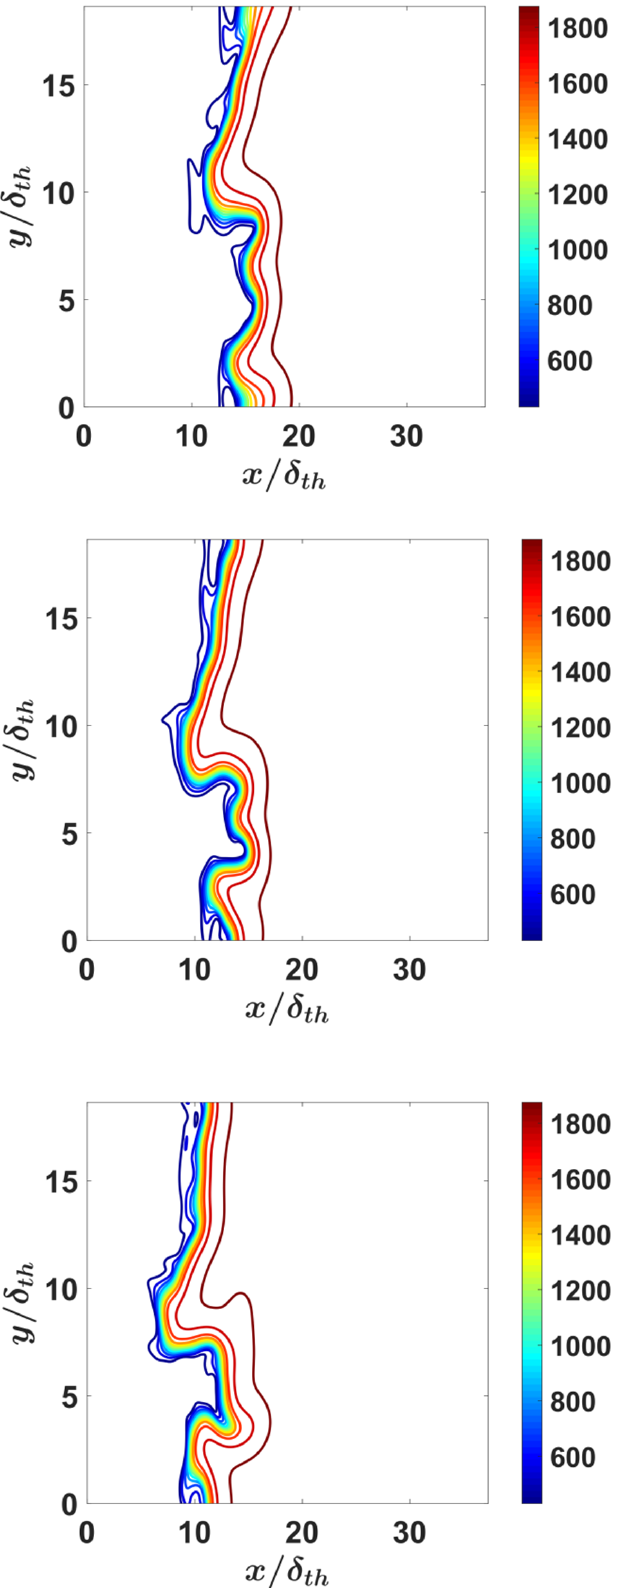
Figure 2. Instantaneous views of the (cid:1855) = 0.8 isosurface for statistically planar turbulent premixed flames (first column) and homogeneous MILD combustion cases (second column) for initial (cid:1873) (cid:4593) (cid:1845) (cid:3013) ⁄ = 4.0,6.0 and 8.0 (1st–3rd rows).